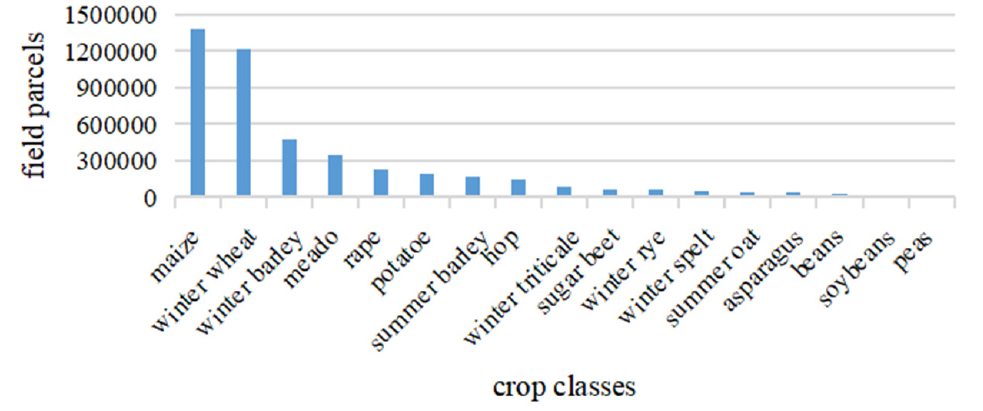
Figure 7. Information of labeled samples and the non-uniform distribution of classes in Munich data set.